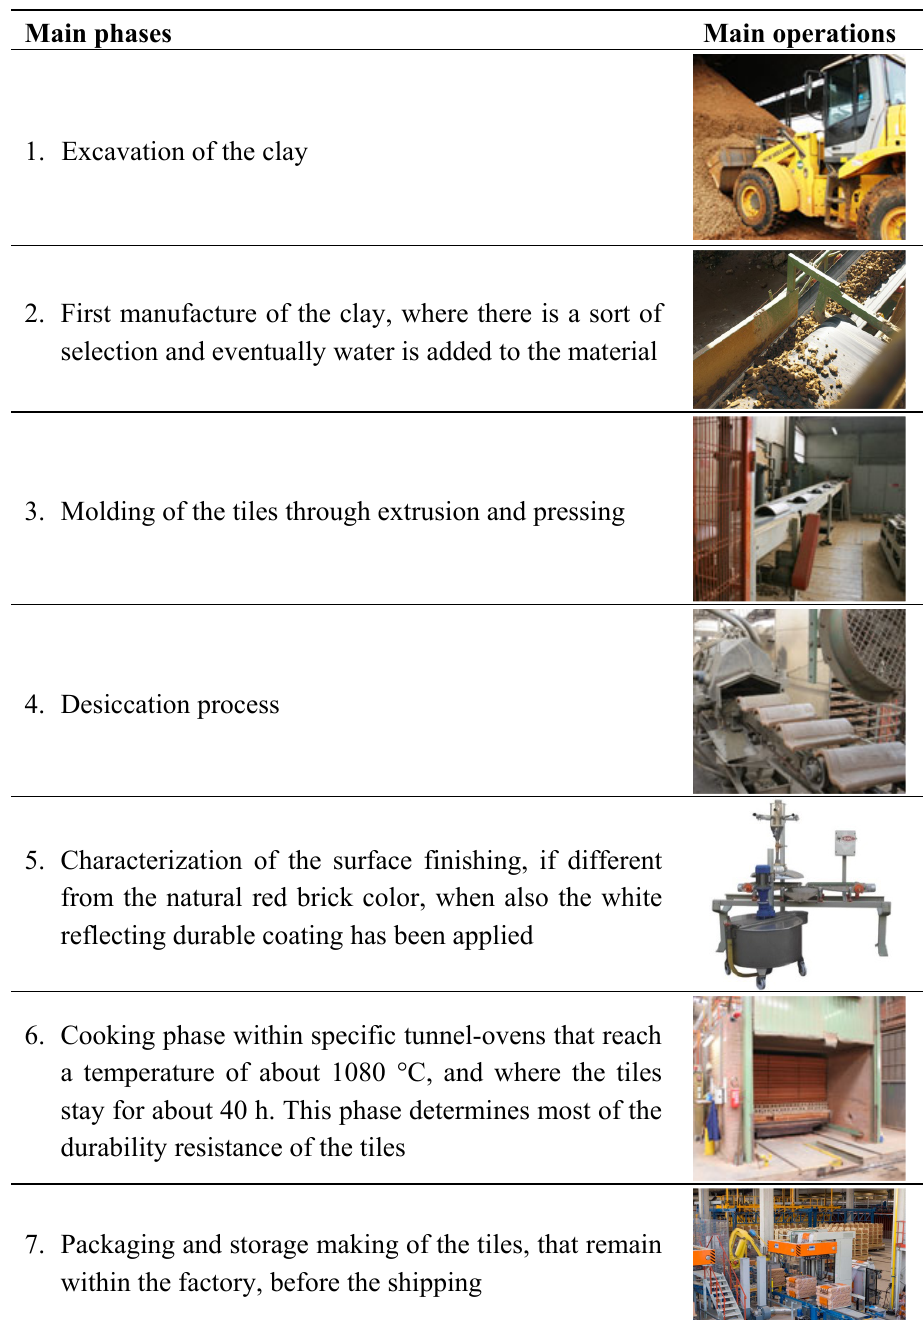
Table 2. Production process of traditional and prototyped